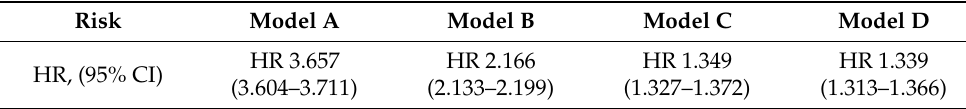
Table 4. Risk of VT/VF/CA in patients with and without